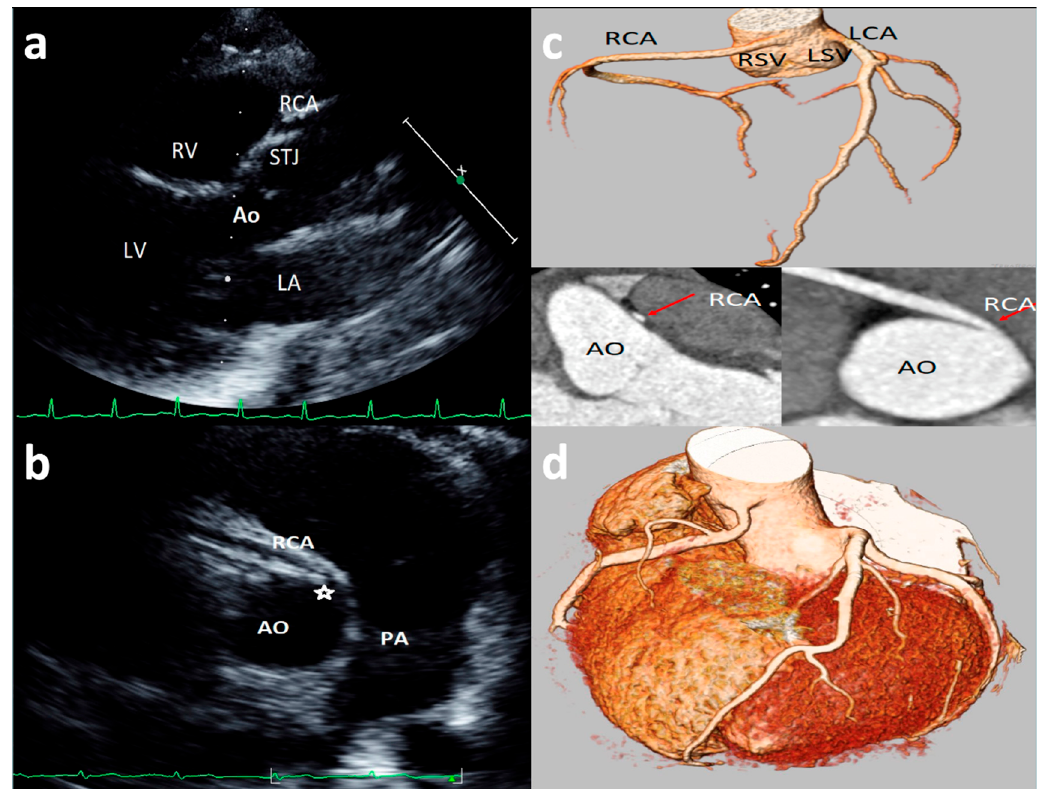
Figure 3. Asymptomatic 17-year-old boy evaluated for the presence of two premature ventricular beats at peak of stress test in routine preparticipation evaluation for sports competition. Parasternal long-axis view showing right coronary artery (RCA) high take-off coronary artery above the sinus of Valsalva ( a ). The acute angulation origin is clearly visualized in short-axis view ( b ) and was confirmed at CT ( c ). After CT confirmation of the defect, a myocardial scintigraphy was performed revealing a small ischemia (8%) in the RCA territory at peak. We advised sport restriction. Ao = aorta, LCA = left common coronary artery, RCA = right coronary artery, LSV = left sinus of Valsalva, RSV = right sinus of Valsalva. ( d ) is an example of 73-year-old man showing symptoms of dyspnea. 3D-Volume Rendering CCTA showing the right dominant coronary artery (RCA) high take-off two centimeters distal to the sinutubular junction at the level of the anterior ascending aortic wall.